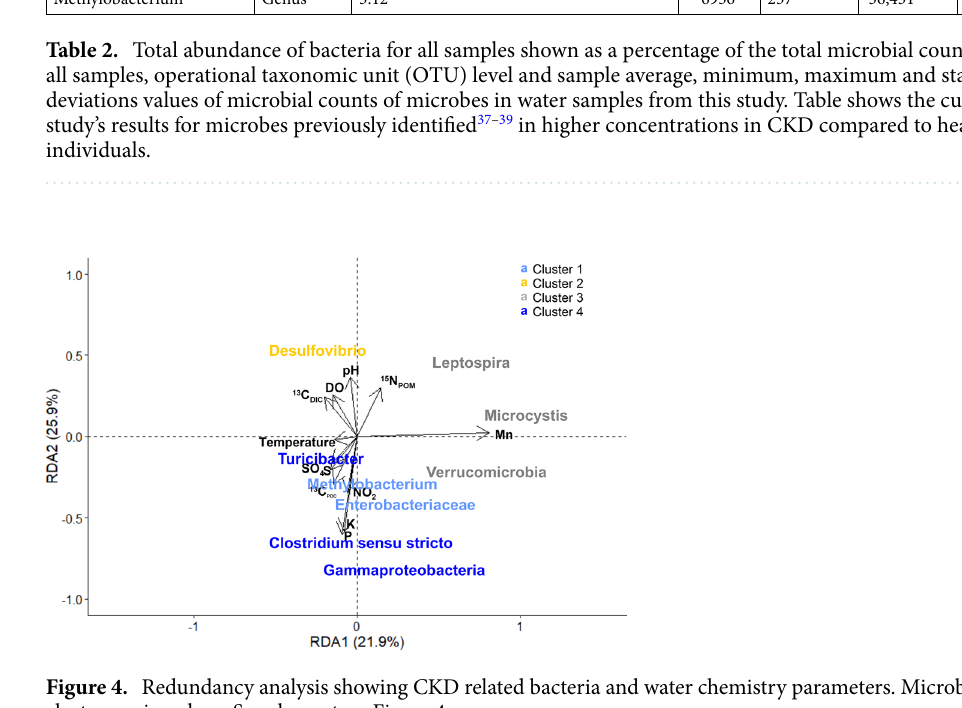
Figure 4. Redundancy analysis showing CKD related bacteria and water chemistry parameters. Microbial clusters assigned per Supplementary Figure